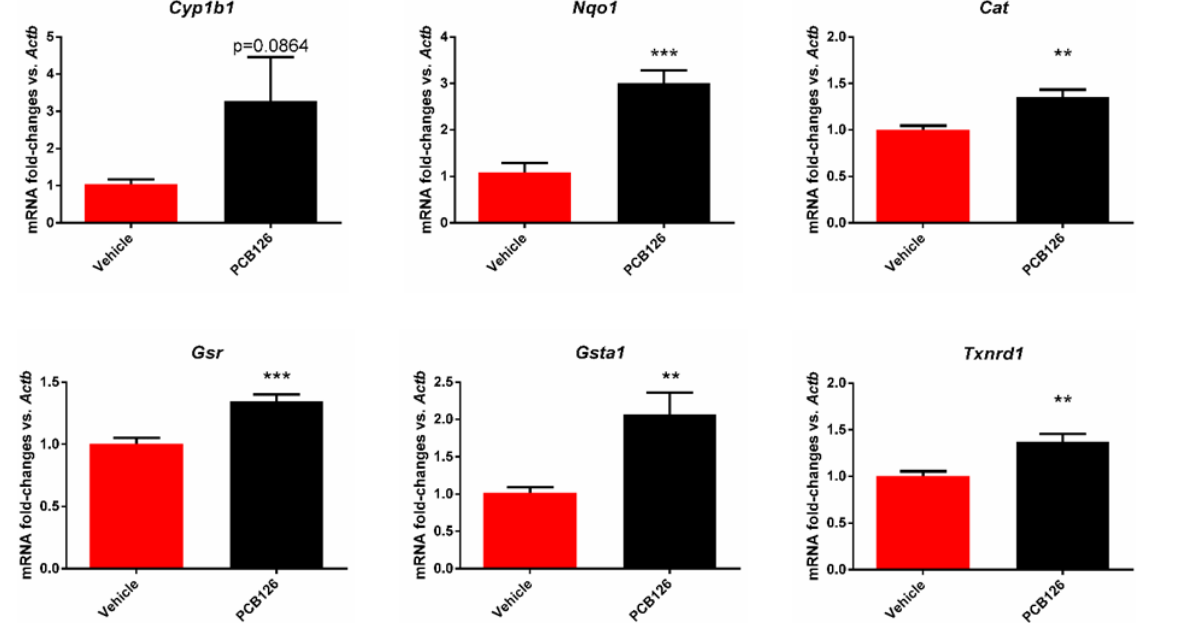
Figure 2. mRNA expression of Cyp1b1, Nqo1 , Cat , Gsr , Gsta1, and Txnrd1 in PCB 126-treated MCECs. mRNA expression of AhR transcriptional target Cyp1b1 , and the expression of oxidative stress-sensitive genes regulated by the NRF2 pathway, including Nqo1 , Cat , Gsr , Txnrd1 , and Gsta1 , is measured in MCECs 24 h after being treated with the vehicle (Red) or 4.4 µm PCB 126 (Black). Sample size: n = 6. Data are shown as the mean ± SEM. ** p ≤ 0.01 and *** p ≤ 0.001; otherwise, the p -values are shown above the bar.